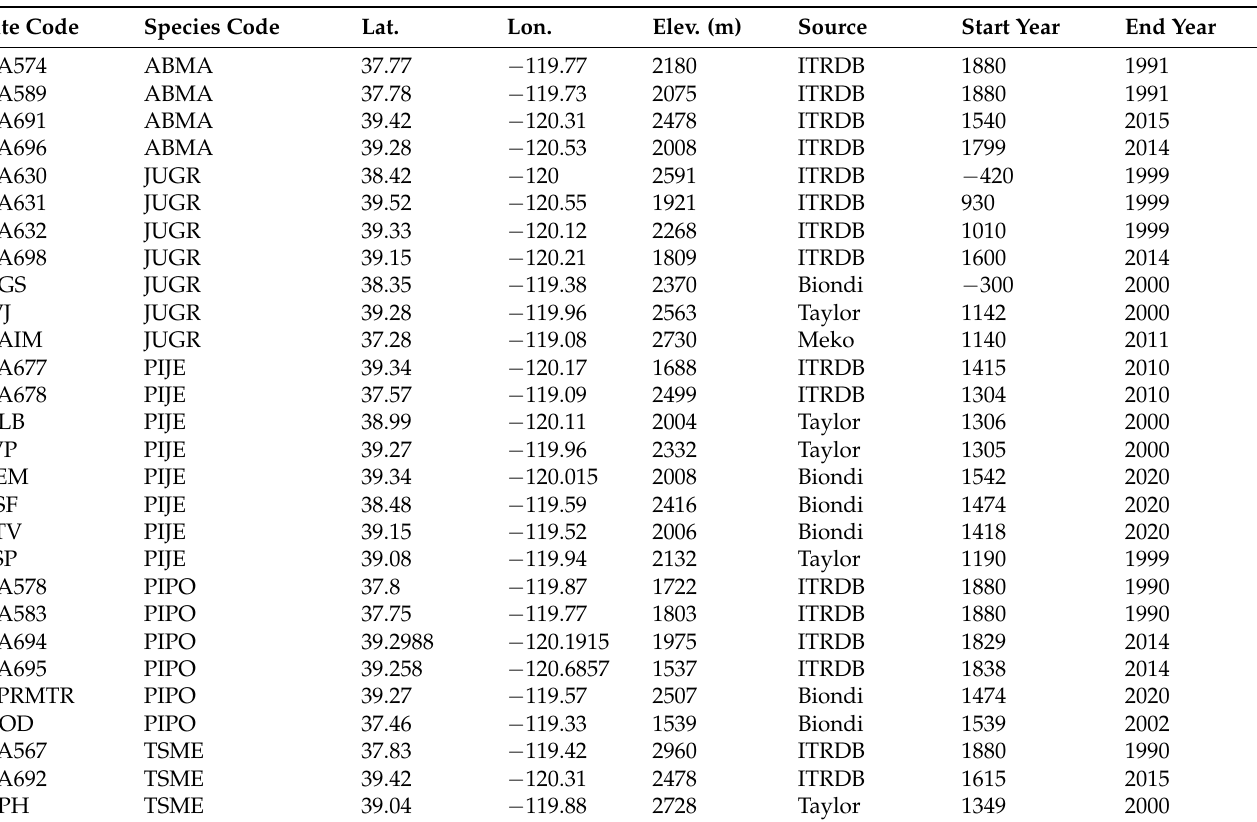
Table 1. Complete pool of predictor chronologies used in various tree-ring reconstructions of